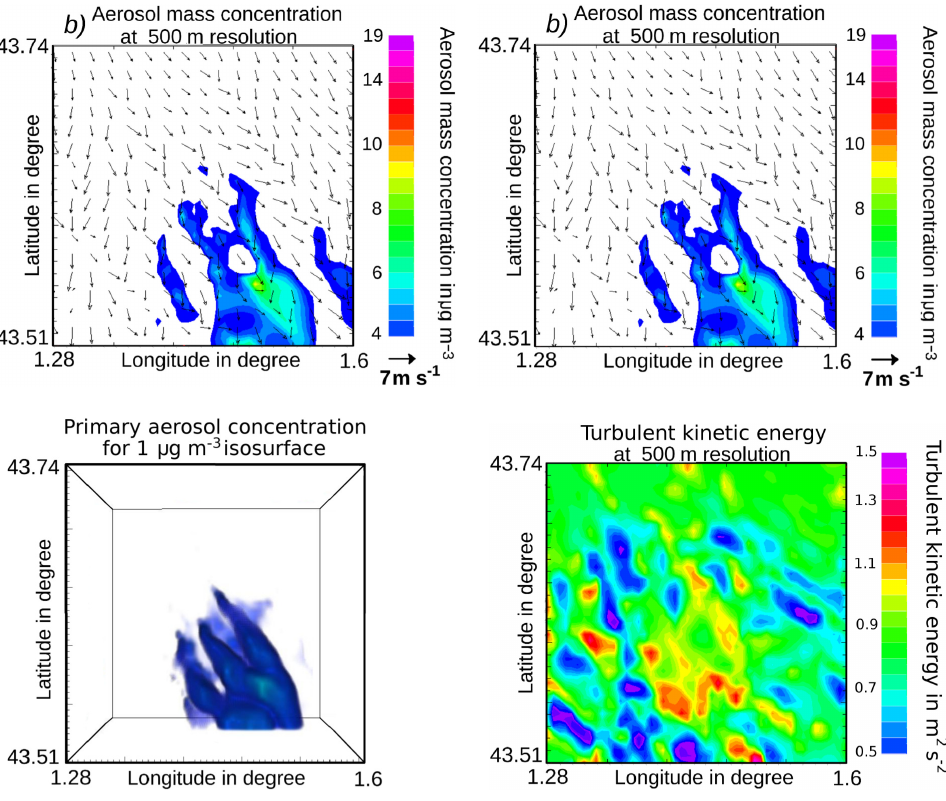
Fig. 9. (a) total aerosol mass concentration over the 2nd domain. (b) aerosol mass concentration over the 3rd domain. (c) 3-dimensional view of primary aerosol mass concentration for 1µgm − 3 isosurface. (d) Turbulent kinetic energy over the 3rd domain. All results for 3 July at